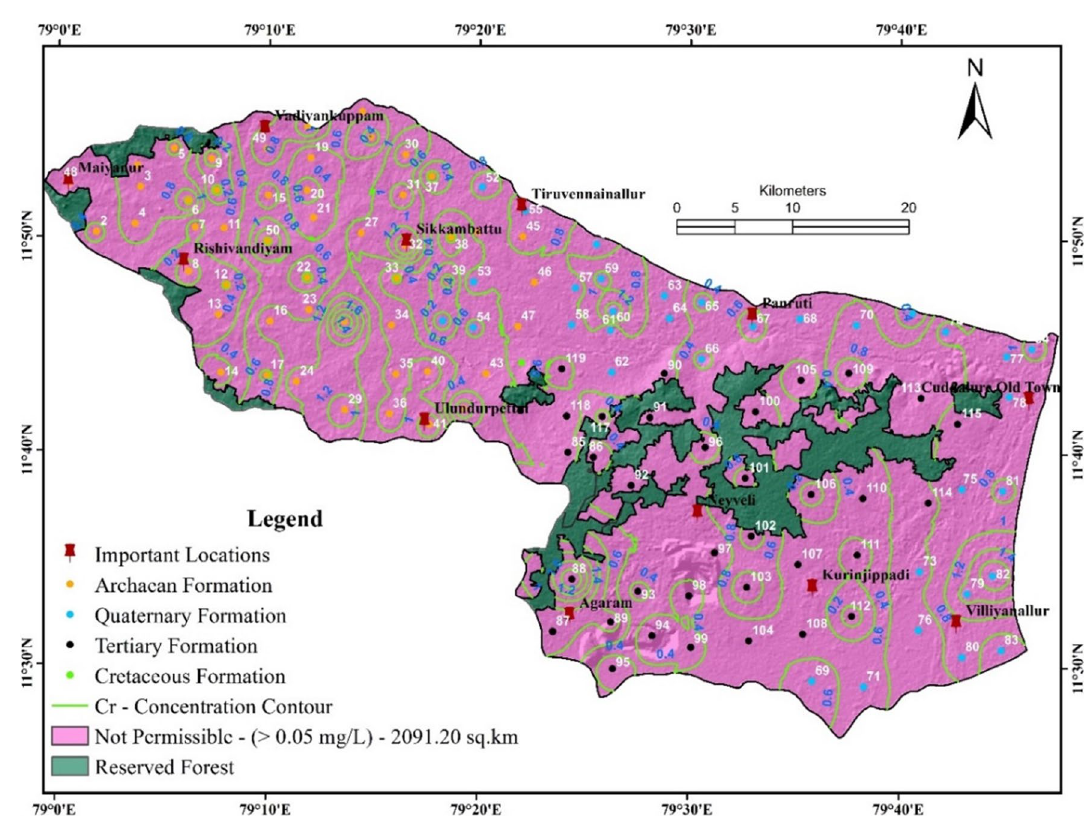
Fig. 7 Spatial variation with contour map of chromium in